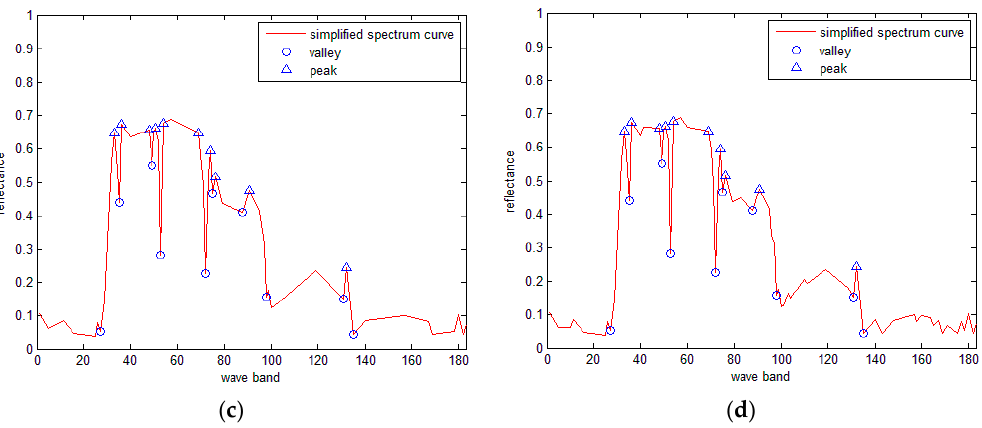
Figure 5. The results of the IDP algorithm under SRAI-restriction with10 peak and 10 valley points. ( a ) The original spectral curve, ( b ) 30 retained points, ( c ) 50 retained points, and ( d ) 70 retained points.